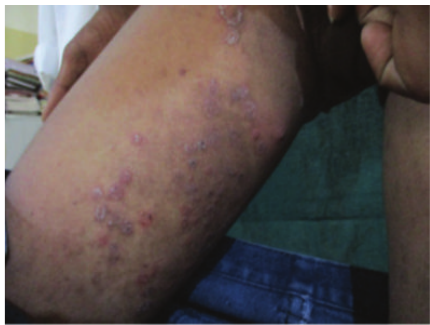
Figure 2: Vasculitic lesions on the legs.